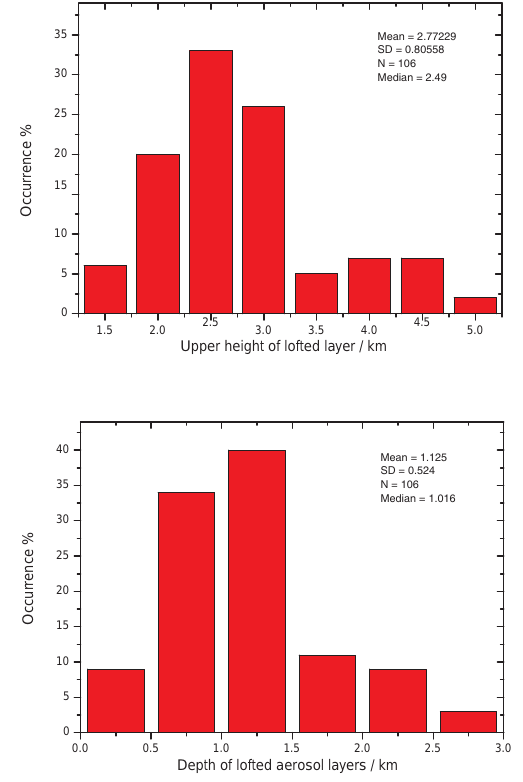
Figure 6. Histogram of lofted-layer heights and